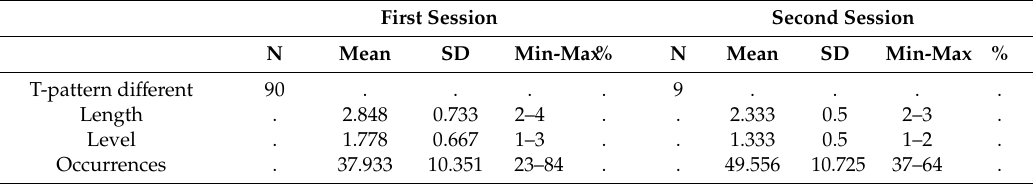
Table 5. Descriptive statistics of the T-patterns detected in each